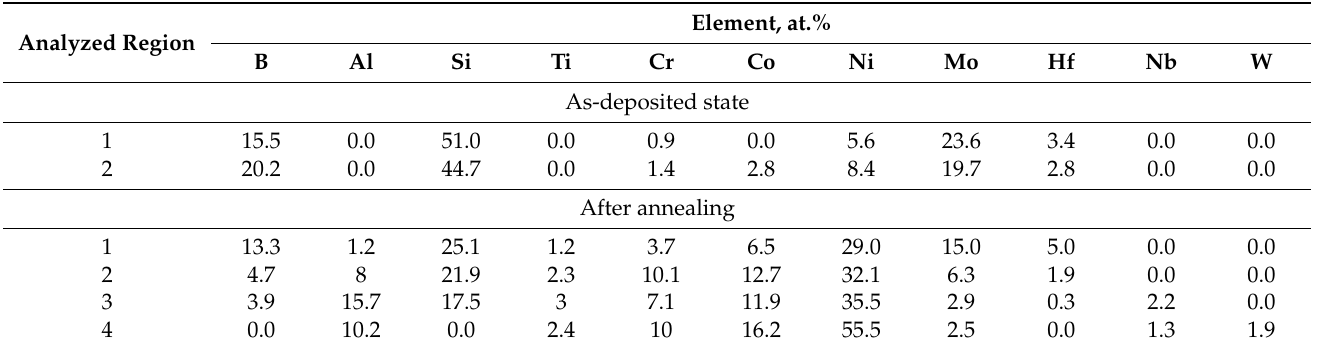
Table 2. EDS data for the coatings produced using the MoSi 2 –MoB–HfB 2 electrode before and after